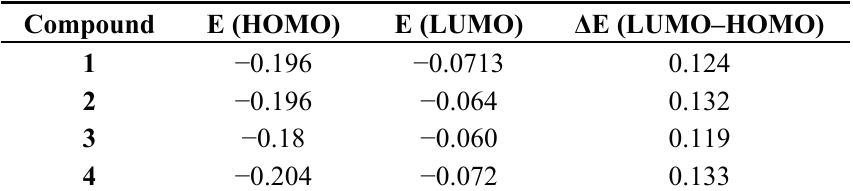
Figure 6. HOMO, LUMO surfaces of compounds 1 – 4 simulated at B3LYP/6-31G (d, p). Table 9. Frontier orbital energy (a.